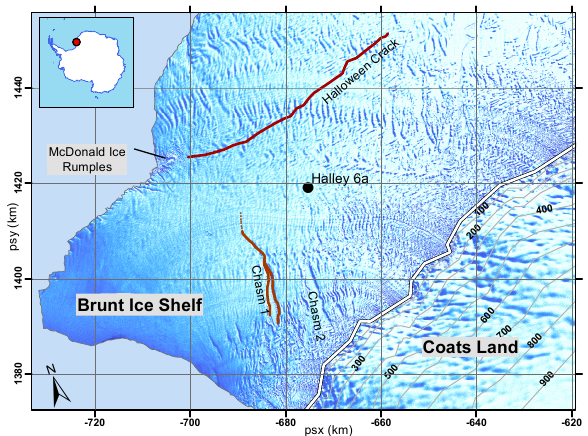
Figure 1. The Brunt Ice Shelf lies off Coats Land on the east side of the Weddell Sea, Antarctica (inset). The surface of the East Antarc- tic Ice Sheet slopes steeply down to the grounding line marked by a white line; elevation contours are at 100m intervals. The ice shelf is partially grounded at the McDonald Ice Rumples. After several decades of sustained ice shelf growth, two rifts have developed in the past 2 years, marked by red lines. The first was an extension of a dormant rift known locally as Chasm 1; the second appeared on 31 October 2016 and is known as Halloween Crack. Halley Re- search Station was re-located to the position marked “Halley 6a” in January 2017. Projection is Antarctic Polar Stereographic (WGS84, EPSG: